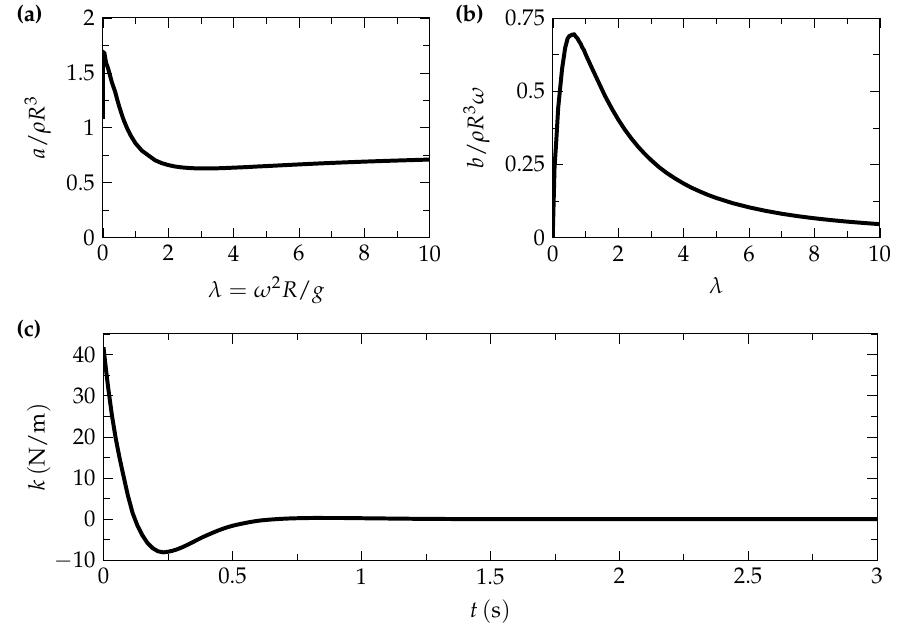
Figure 4. Plots of the dimensionless ( a ) added mass and ( b ) damping coefficients (see Equation (10) for the definitions) versus the dimensionless parameter λ . ( c ) Plot of impulse response function (IRF) as a function of